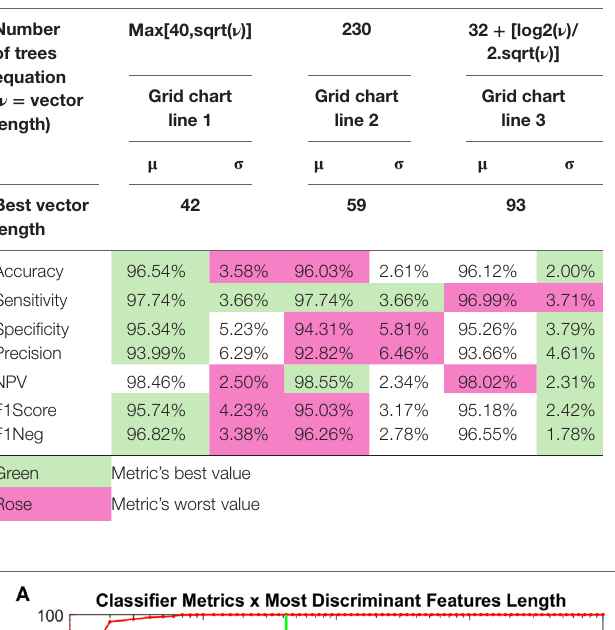
TaBle 2 | Comparison of the most discriminant 10-round training and validation results using the three selected equations for the number of trees in each iteration as function of the ranked vector length.